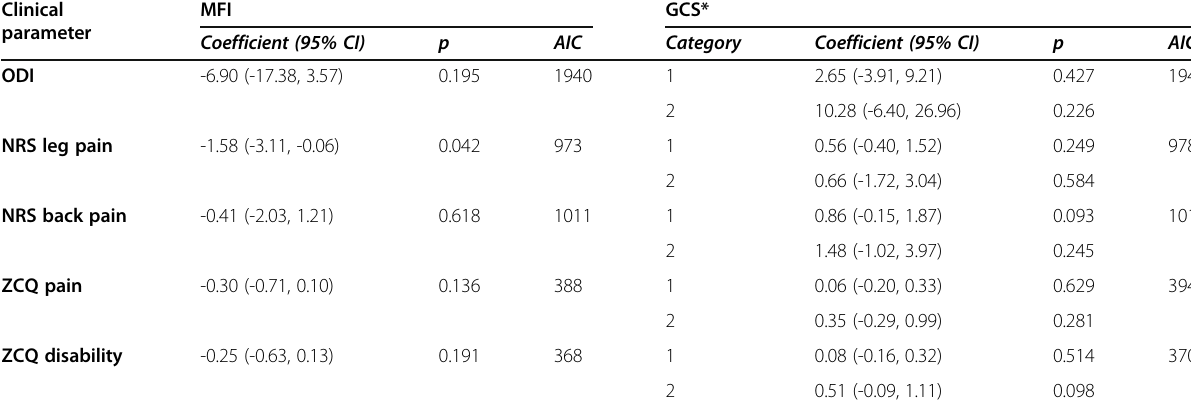
Table 5 Univariate regression analyses Clinical